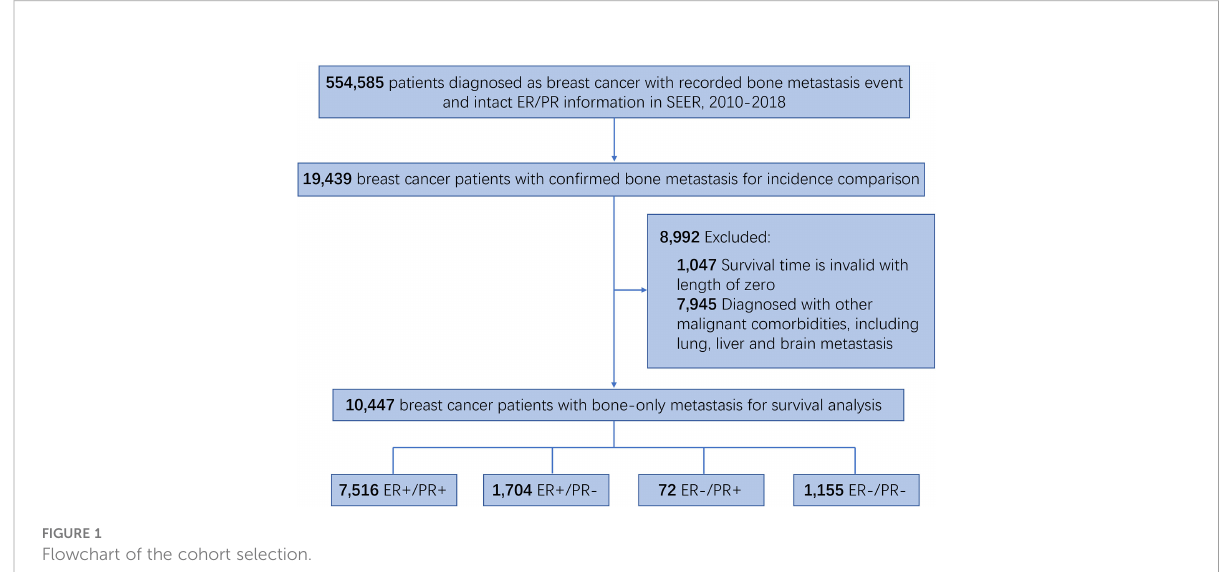
FIGURE 1 Flowchart of the cohort selection.